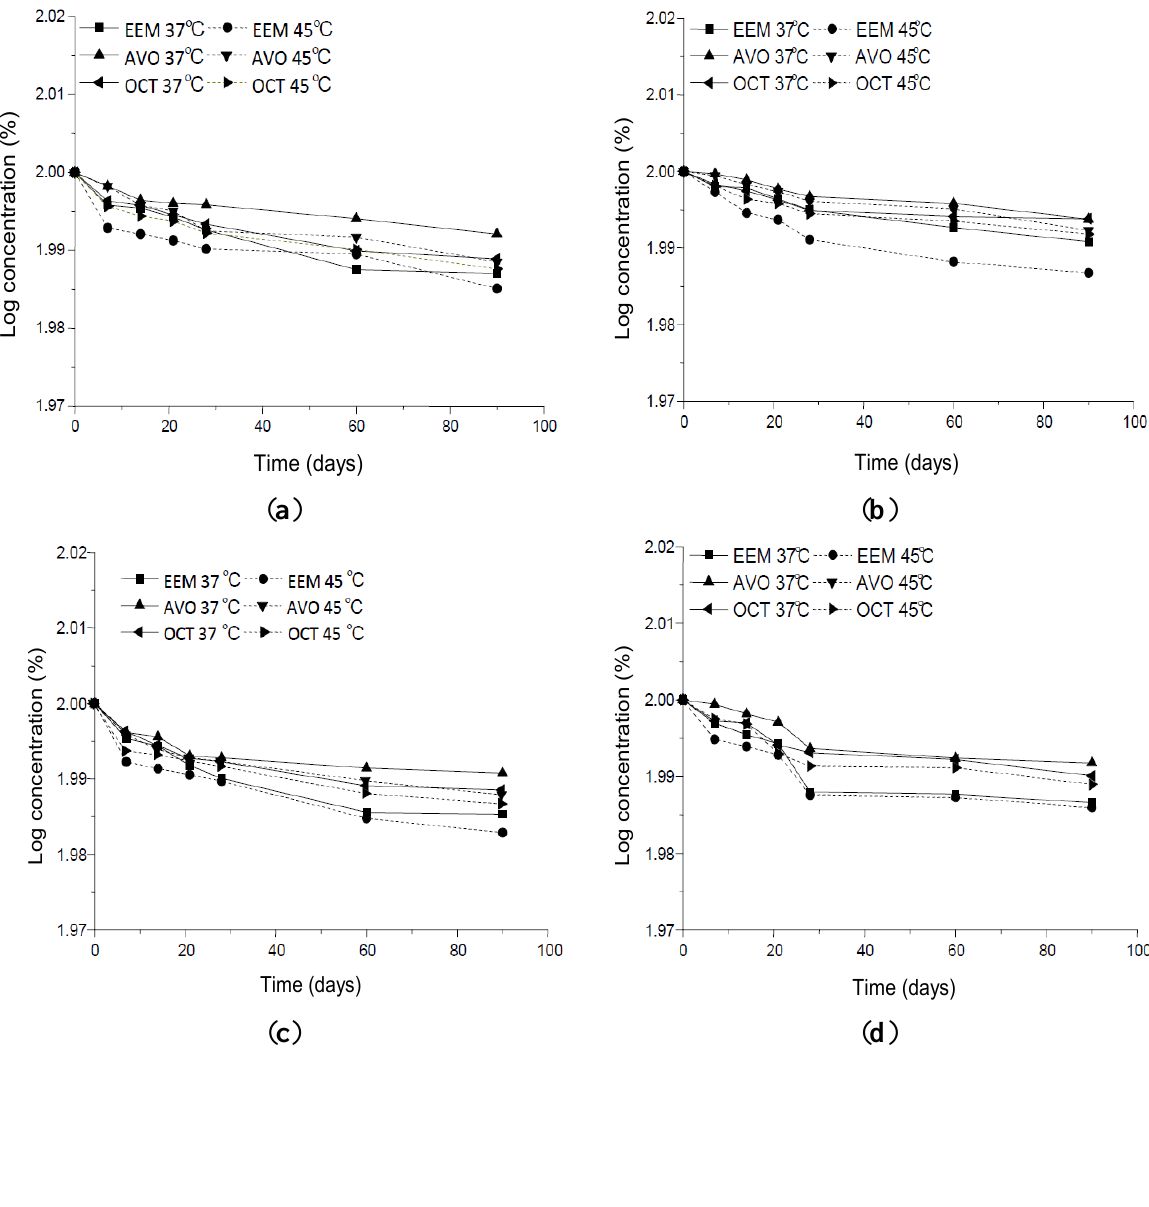
, ( c ) TiO and ( d ) ZnO, expressed as logs of 4 2